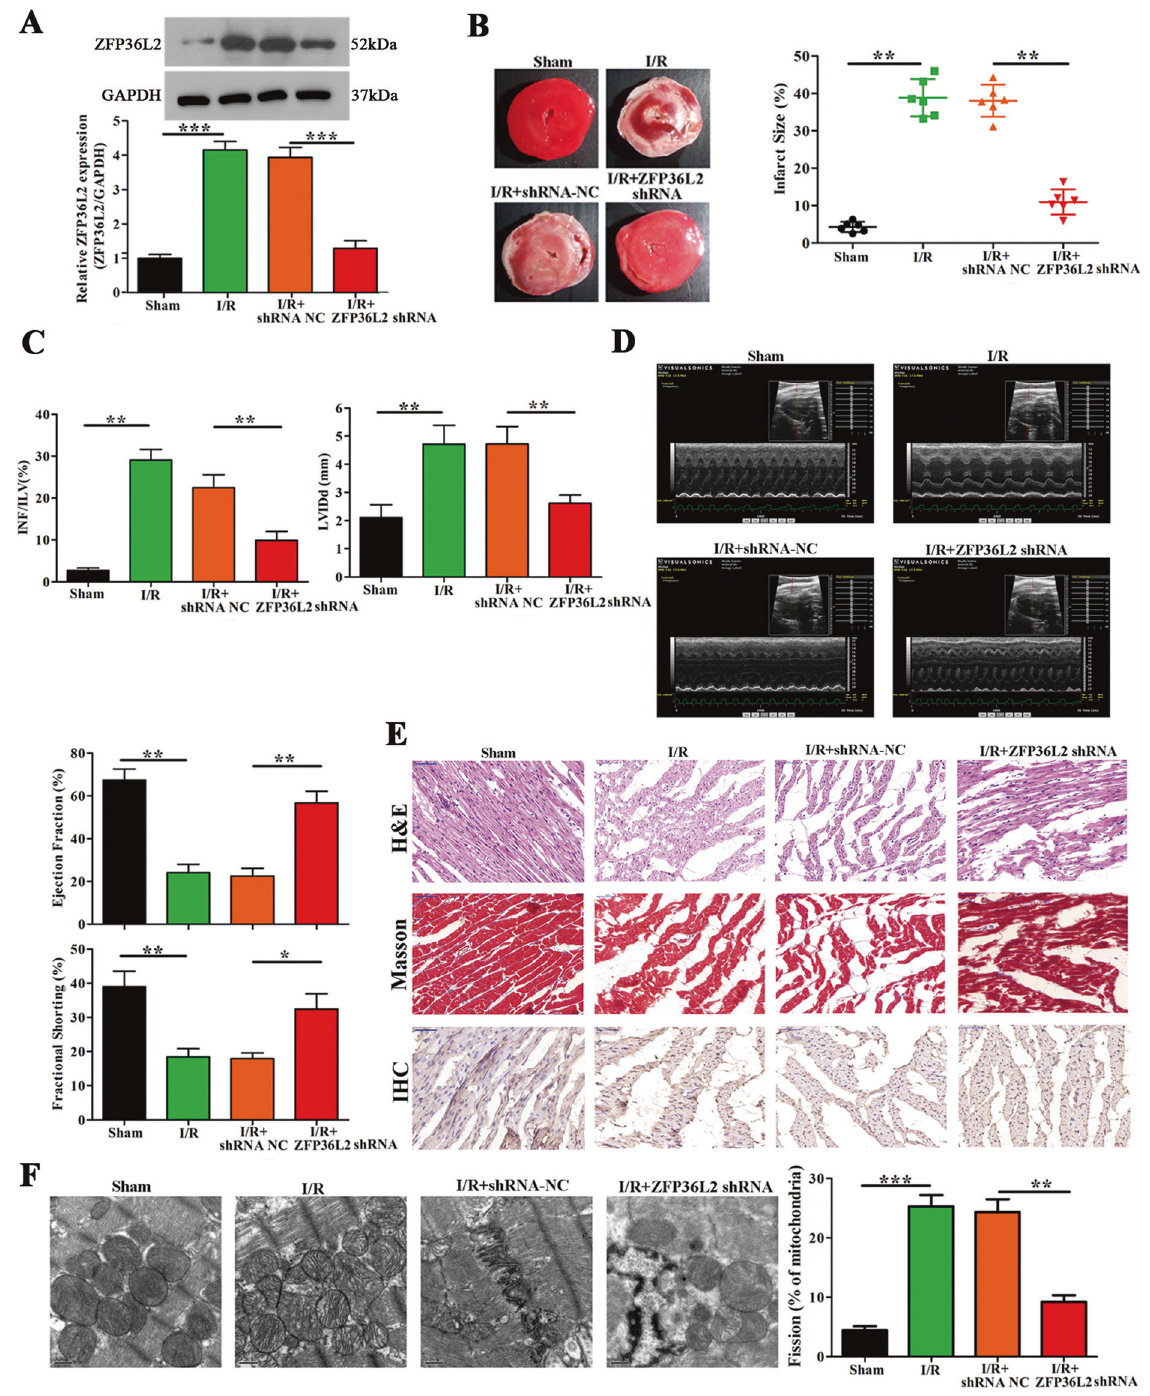
Fig. 1 ZFP36L2 knockdown inhibites myocardial I/R injury and attenuates mitochondrial fusion and fi ssion in vivo. A A myocardial I/R injury model was established by inducing ischemia for 45 min following 4 h of reperfusion ( n = 6 per group). ZFP36L2 shRNA and shRNA-NC were intraperitoneally administered 24 h before induction of I/R injury. RNA was isolated from cardiomyocytes and mRNA and protein levels of ZFP36L2 were determined by qRT-PCR and western blot ( n = 6). B The left panel shows representative images of tissue samples. The right panel indicates infarction size (%) ( n = 6). C Quanti fi cation of the extent of injury measured by infarction area/left ventricle (INF/LV) and diastolic diameter of the left ventricle (LVIDd) ( n = 6). D Representative echocardiograms at 4 h post I/R injury. The percentage of ejection fraction (EF) and fractional shorting (FS) were shown ( n = 6). E Representative images of H&E and Masson ’ s trichrome staining and immunohistochemistry staining for ZFP36L2 in LV sections (Scale bar = 50 μ m) ( n = 6). F Representative TEM images of heart tissues shown in the left panel and the corresponding quanti fi cation of fragmented mitochondria shown in the right panel (Scale bar = 0.5 μ m) ( n = 6). * P < 0.05; ** P < 0.01; *** P < 0.001.